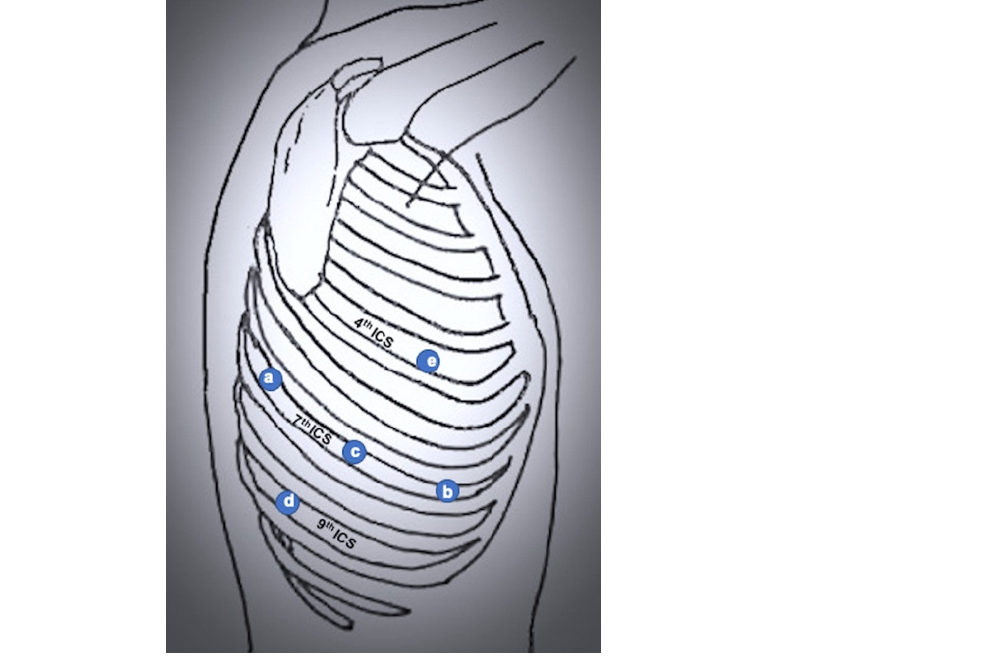
Figure 6. Port mapping of 4-port completely portal robotic lobectomy. ( a ) Robotic left arm 1 (lung retraction); ( b ) robotic left arm 2; ( c ) camera port; ( d ) assistant port; ( e ) robotic right arm. Table 1. Main robotic port strategies and their potential advantages and disadvantages.